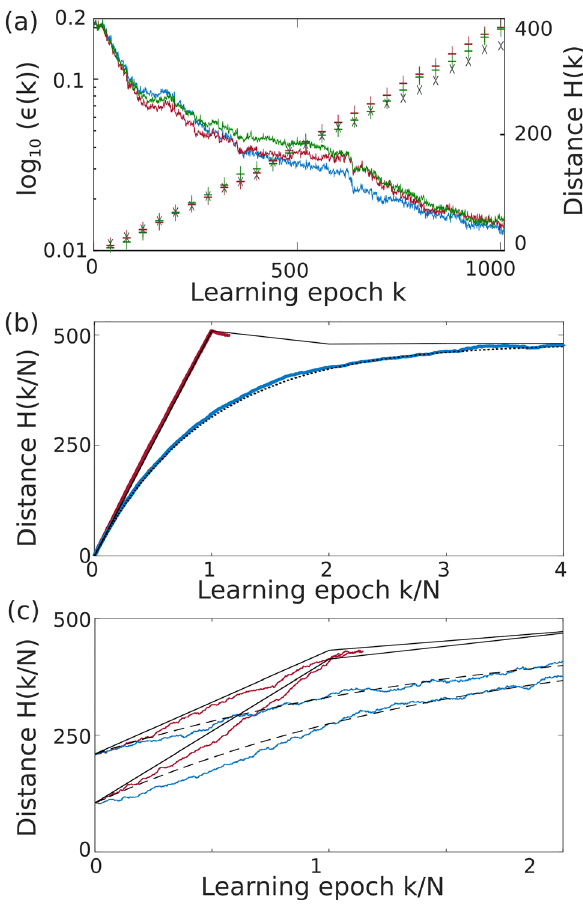
Figure 4: (a) Three minimizers starting from identical position are measured in parallel. The red and green (slaves) optimization paths test the dimension l ( k ) determined by the blue minimizer (master), reward of each mutationare evaluated and appliedindividually.The lines show the individual errors on a logarithmic scale, crosses depict the Hamming distance ’ s evolution between the three minimizers. (b) Hamming distance evolution with learning epoch k normalized by the network ’ s Size N . Random mutation (blue line) leads to a smooth saturation function behaviour, while biased (greedy) mutation (red dashed line) results in linear intervals of length N . (c) The same characteristics are found for two minimizers starting already separated by a distance (1) ≠ 0, and the behaviour is therefore generally true for Boolean learning in noisy